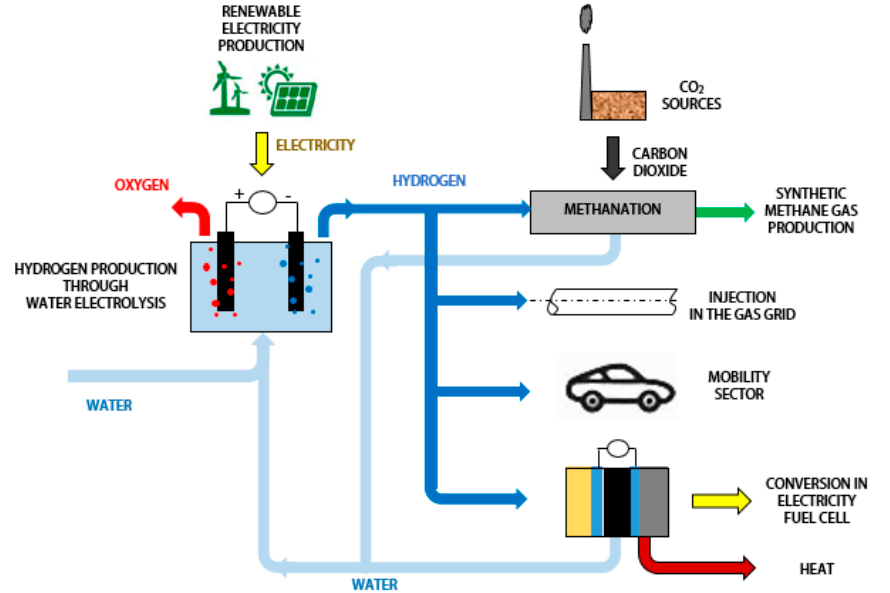
Figure 1. Schematization of Power to Gas (P2G) concept.